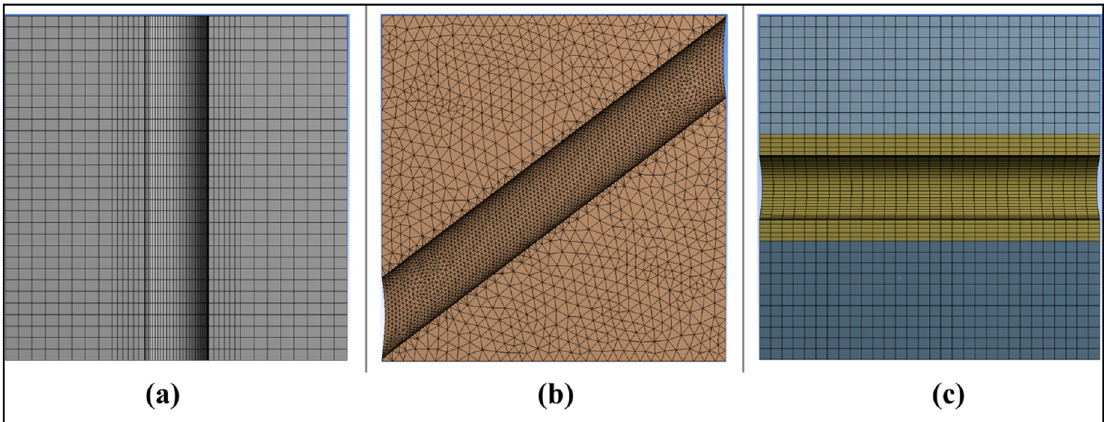
Figure 2. Finite Element Mesh around the drill hole in the three cases ( a ) Vertical drill hole, ( b ) Angular drill hole and ( c ) Horizontal drill hole.